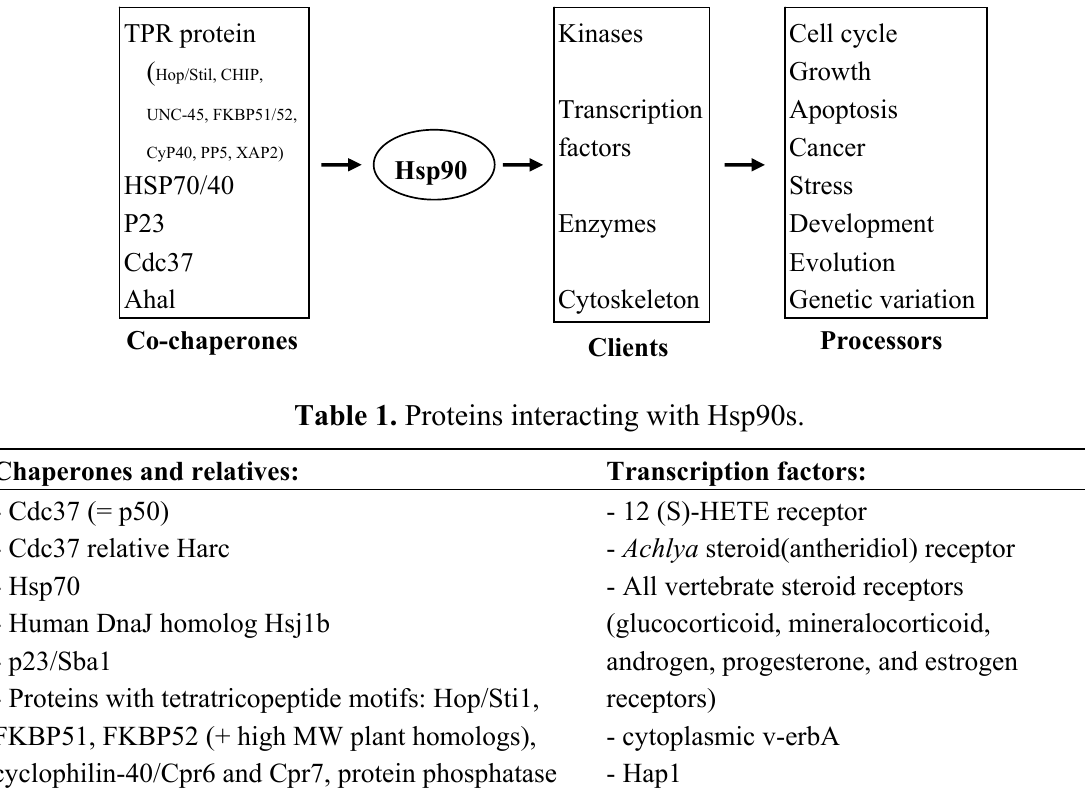
Figure 3. Functions of Hsp90 and co-chaperones identified by interaction with substrates in different developmental phases in cells.